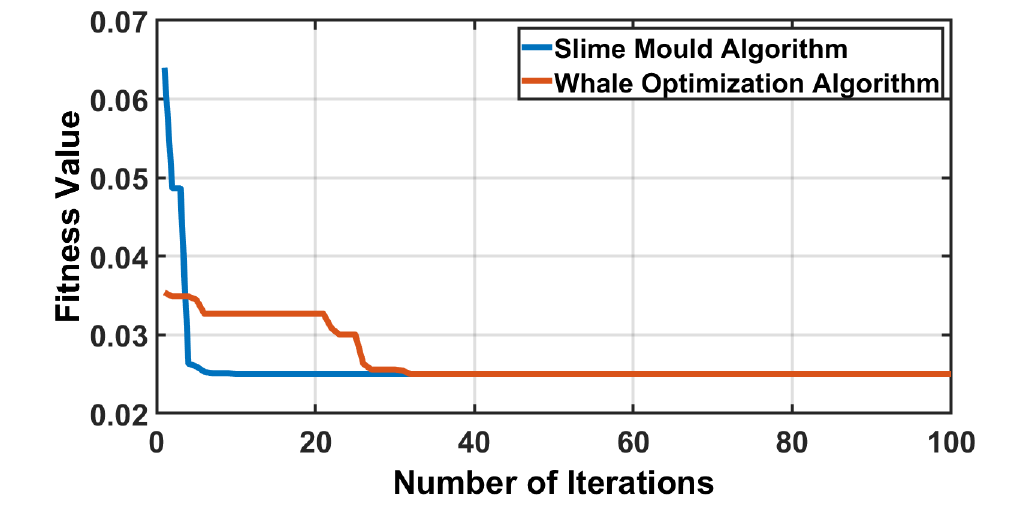
Figure 10. Wrapper algorithms: Fitness values.